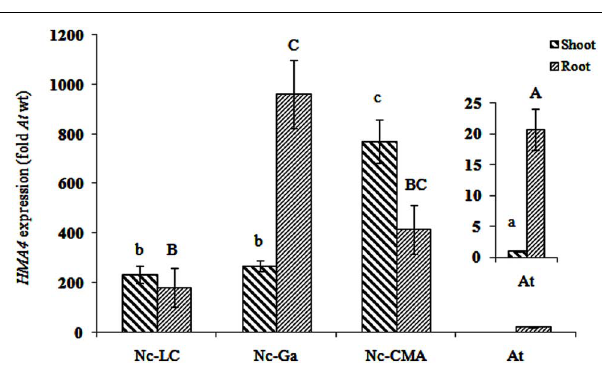
FIGURE 2 | HMA4 expression in three Noccaea caerulescens accessions (fold A. thaliana in shoot) La Calamine (LC), Ganges (Ga) and Col du Mas de l’Aire (CMA) . Significant differences ( P < 0.05) between means are indicated, separately for root and shoot, by different superscripted letters.